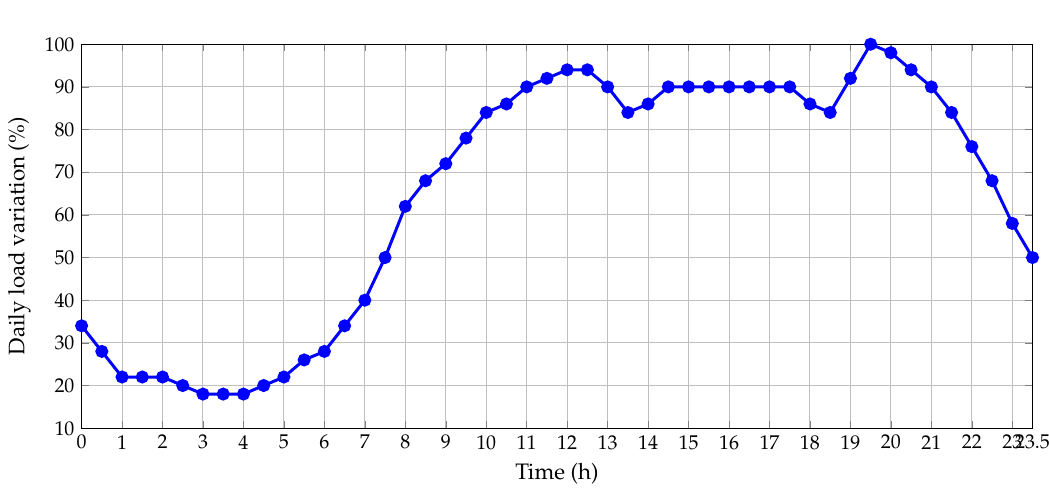
Figure 5. Typical hourly load behavior in Colombia